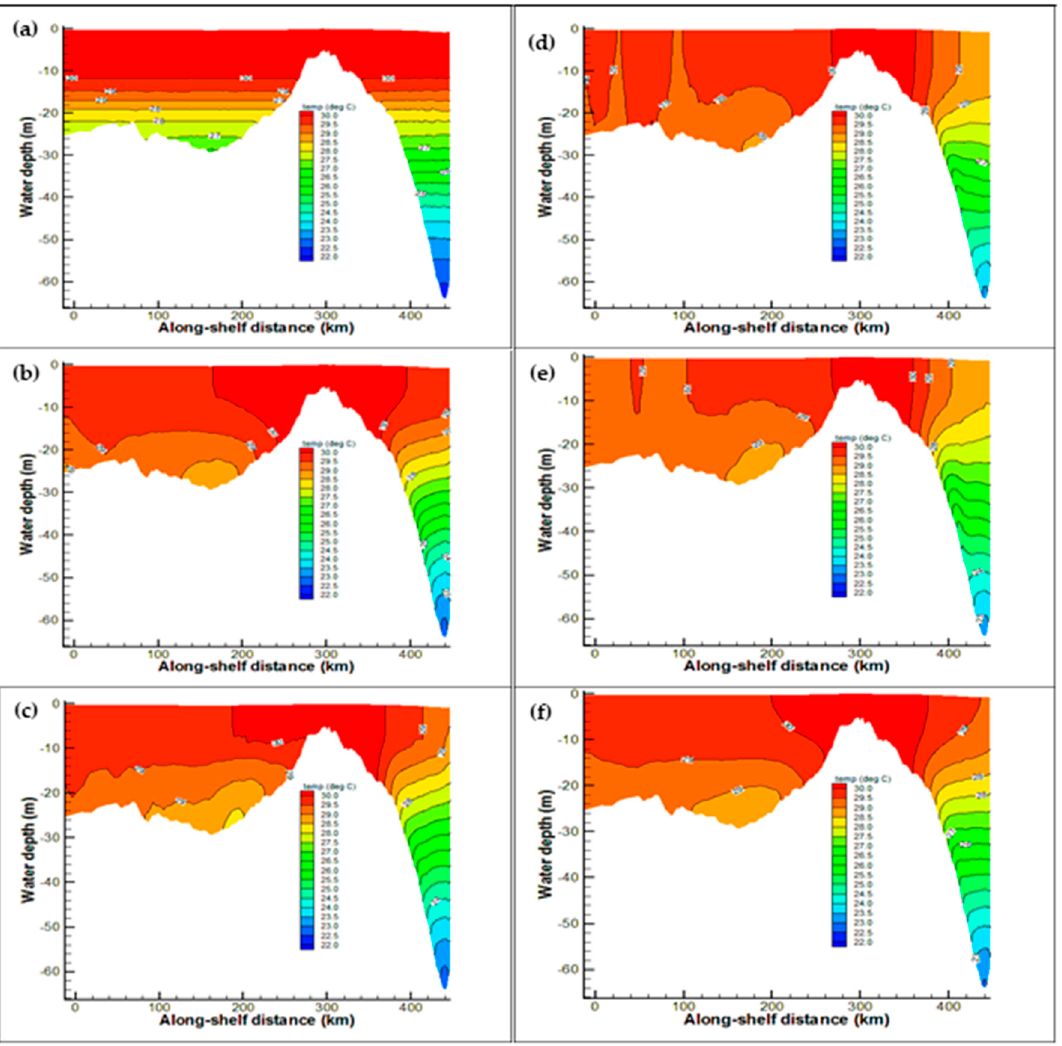
Figure 10. Distribution of simulated temperature across section AS 1 (see Figure 1 for location) on ( a ) 1 October, ( b ) 10 October, ( c ) 17 October, ( d ) 22 October, ( e ) 27 October, ( f ) 1-month average. All snapshots from a) to ( e ) were taken at 12:00 a.m.